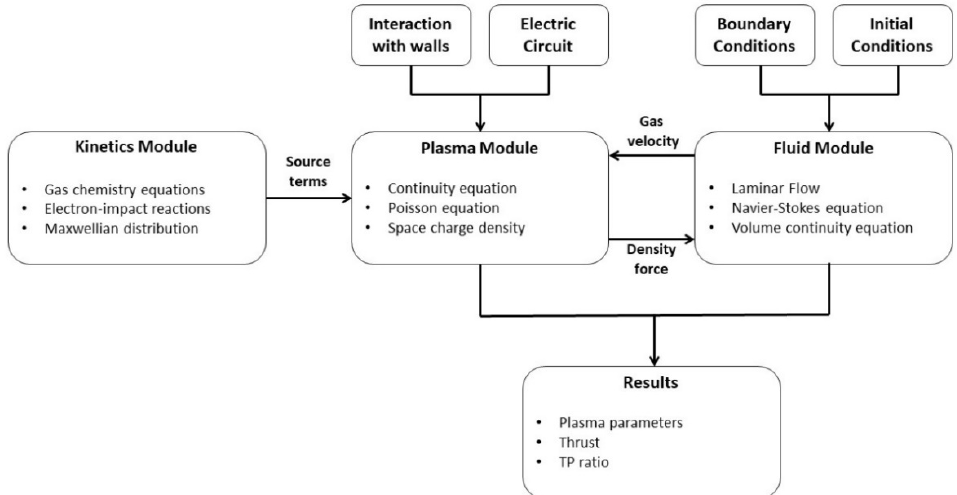
Figure 2. Pseudo ‐ flow chart connecting all modules and entry parameters. Figure 2. Pseudo-flow chart connecting all modules and entry